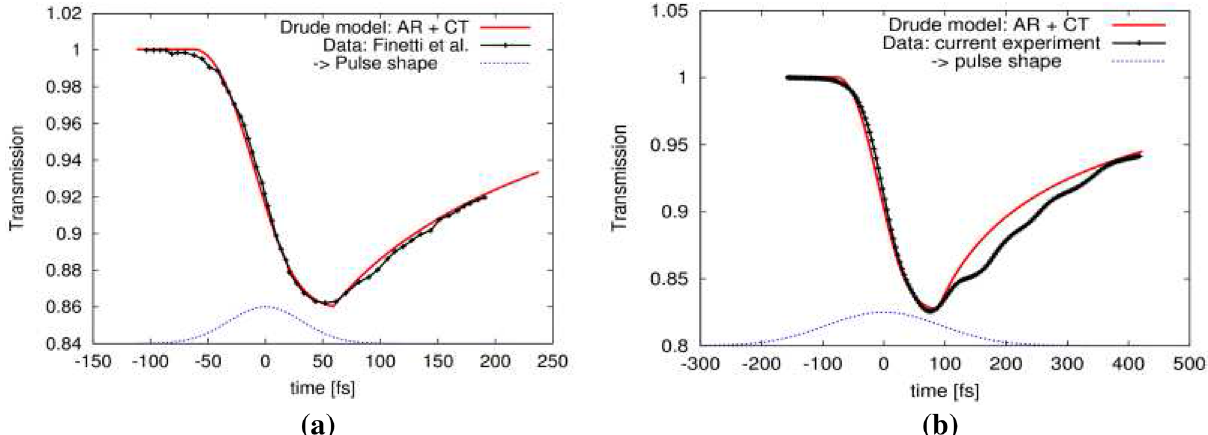
Figure 4. Normalized transmissivity, T ( t )/ T equib of XUV irradiated Si 3 N 4 recorded in the experiment performed at: (a) the FERMI facility by Finetti et al. 3 (pulse duration of ∼ 75 fs FWHM), and (b) in our current experiment (pulse duration of ∼ 220 fs FWHM), when probed with the optical pulses of wavelength (cid:31) = 630 nm. The experimental data represent averages over at least 600 single shots. They are compared with the results of the simulation in case when the Auger recombination (AR) and carrier transport (CT) were taken into account. Temporal profile of XUV pulses is also schematically depicted.